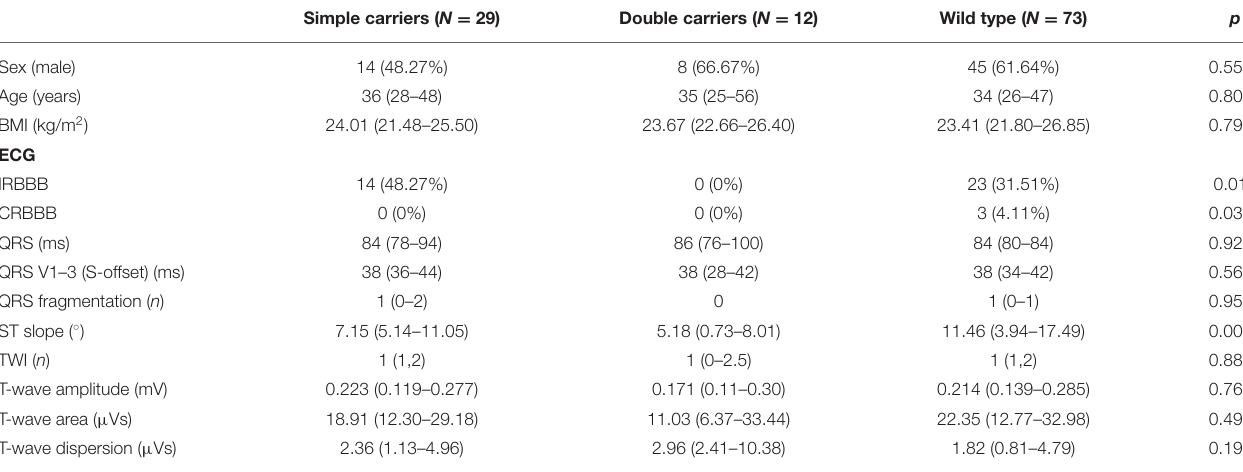
TABLE 3 | Quantitative analysis of the main electrocardiographic parameters in single- and double-mutation carriers and wild-type relatives. Simple carriers ( N = 29) Double carriers ( N = 12)